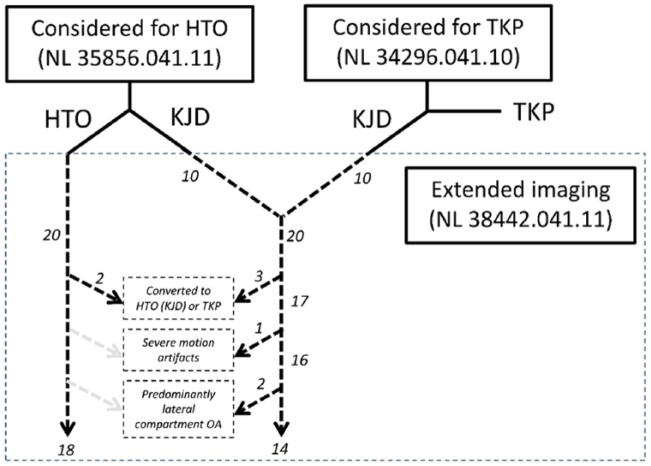
Inclusion flowchart. Patients considered for high tibial osteotomy (HTO)
or total knee arthroplasty (TKP), included in either of the randomized
trials (NL 35856.041.11 or NL 34296.041.10) were asked to participate in
this extended imaging trial (NL 38442.041.11). Additional dGEMRIC
imaging was performed at baseline and after 2 years for HTO patients,
and at baseline, and after 1 and 2 years for knee joint distraction
(KJD) patients.